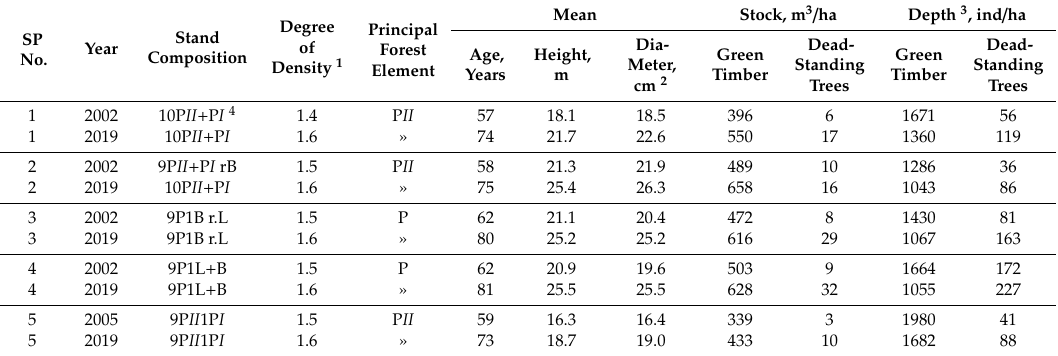
Table 1. Inventory parameters of forest stands in permanent sample plots (SPs) in the establishment year and in 2019. Degree Principal Stand SP of Forest Composition No. Density 1